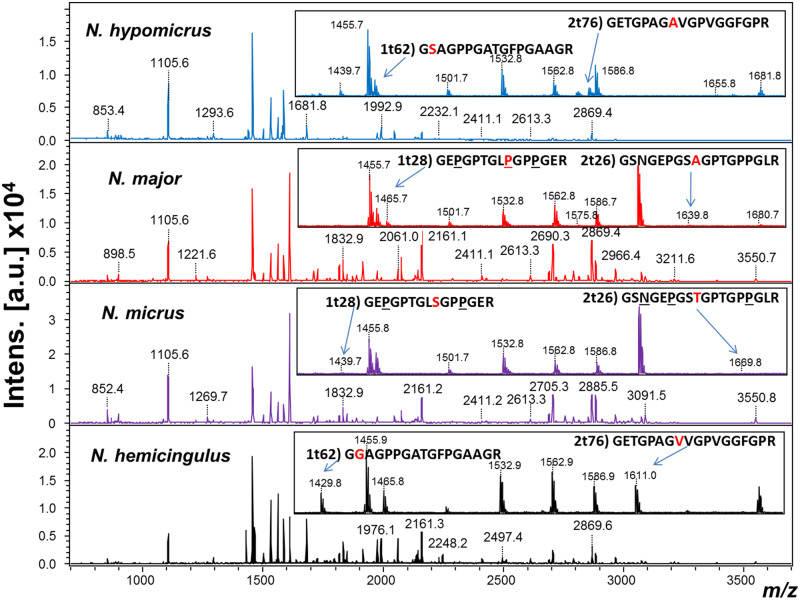
Collagen peptide mass fingerprints for the two Cuban Nesophontes species in comparison to the one from Cayman Brac (N. hemicingulus) and N. hypomicrus from Hispaniola with zoom-in showing some key peptide differences (insets), where red lettering indicates substituted amino acids that vary within the nesophontids. The collagen peptide mass fingerprints of the remaining taxa are shown in supplementary figures S1–S3, Supplementary Material online.